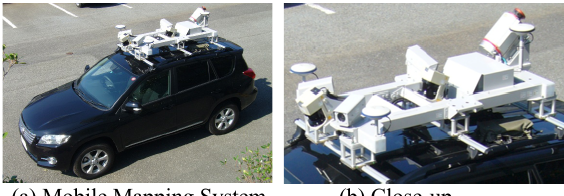
Figure 1. Mobile Mapping